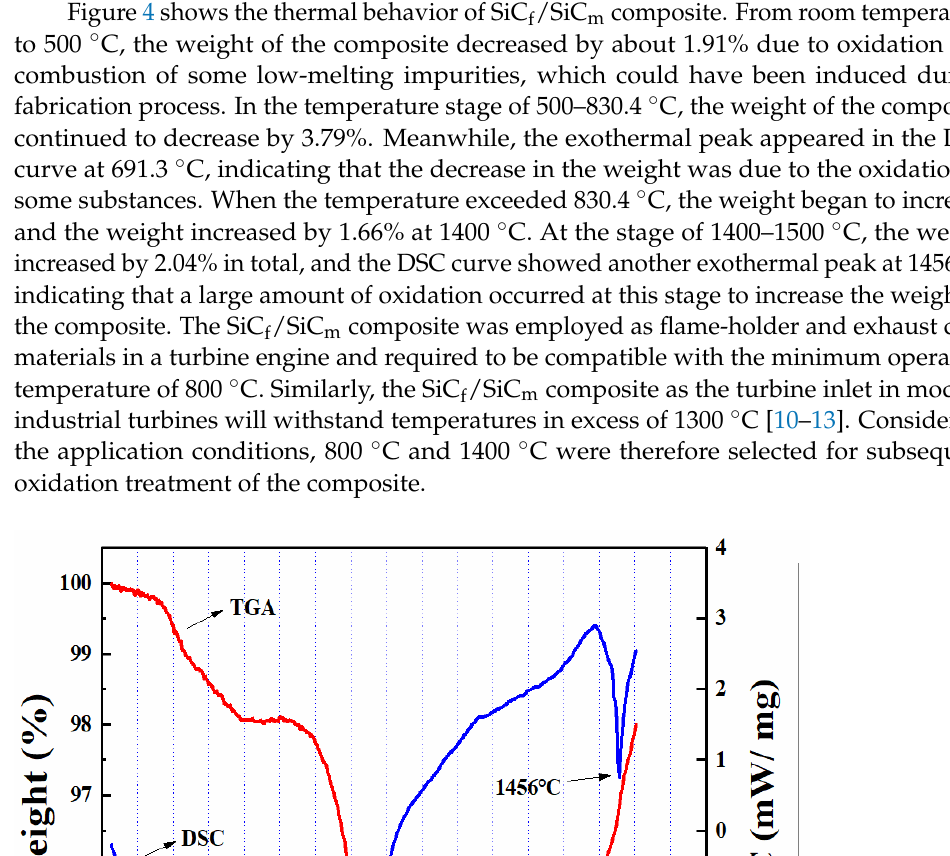
Figure 4. TGA-DSC curves of SiC f /SiC m composites from room temperature to 1500 °C.